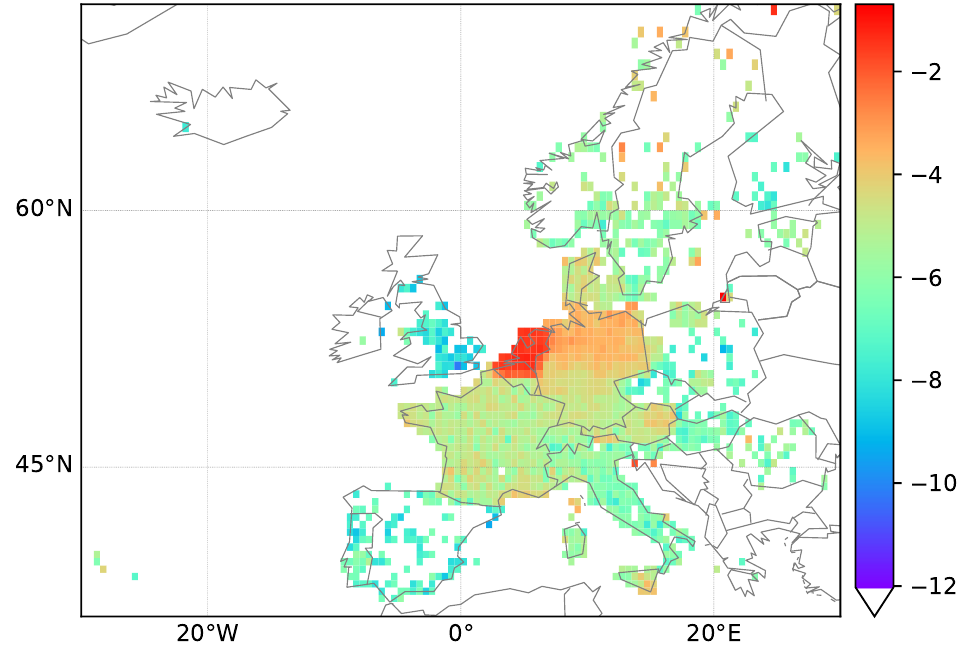
Figure 10. Heatmap of Europe showing the density of streets mapped to Dutch street specifics. Colors indicate the density of streets in this area, thus the logarithmic value of the number of streets normalized by all streets in the cell of the